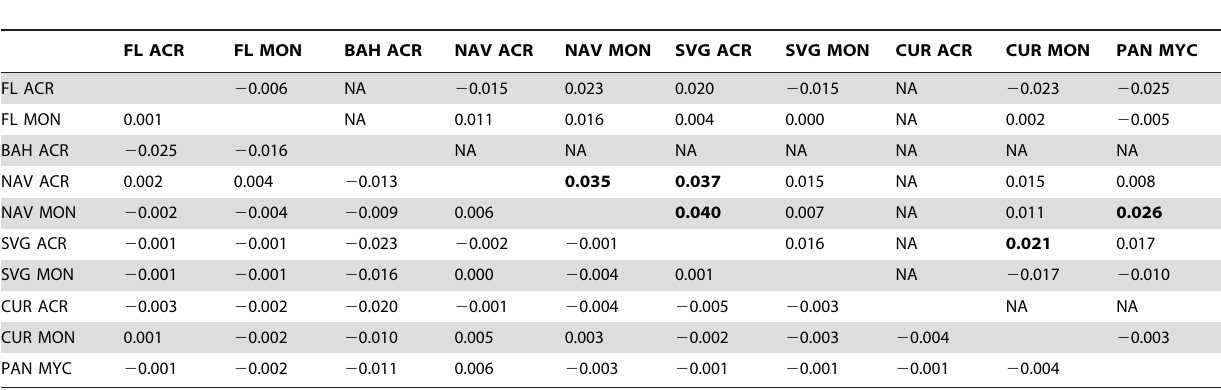
Table 5. Pairwise F ST values for all populations of Coralliophila abbreviata defined by coral host and locality derived from microsatellite (below diagonal) and mtDNA (above diagonal)